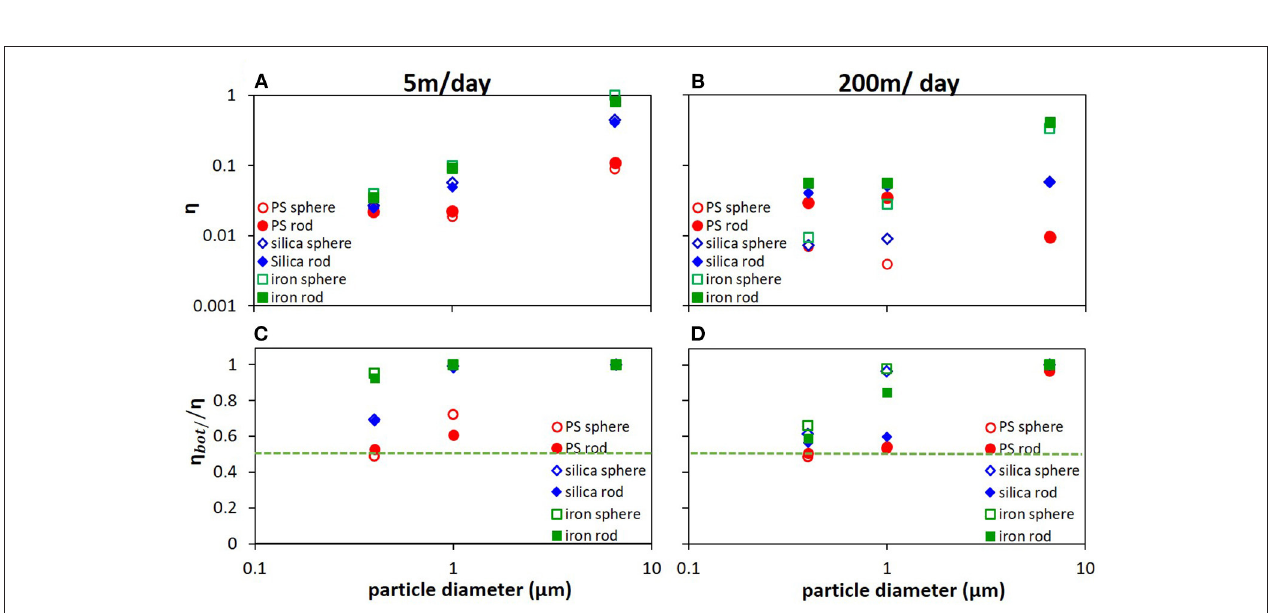
FIGURE 6 | Simulated collector efficiencies (A,B) and the ratios of particles attached on the bottom plate to the total attachment (C,D) as a function of particle size for different particles: polystyrene spheres (open red circles), polystyrene rods (closed red circles), silica spheres (open blue diamonds), silica rods (closed blue diamonds), iron spheres (open green squares) and iron rods (closed green squares). The green dotted line illustrated where attachment on top plate equaled to that on bottom plate (i.e., η bot /η = 0.5). Simulations were from parallel plate model of Dimension I, under pore water velocity of 5 (A,C) and 200 m/day (B,D) with flow perpendicular to gravity direction. The statistical error was about 5–10%. Other simulation conditions were identical as those for Figure 3 .